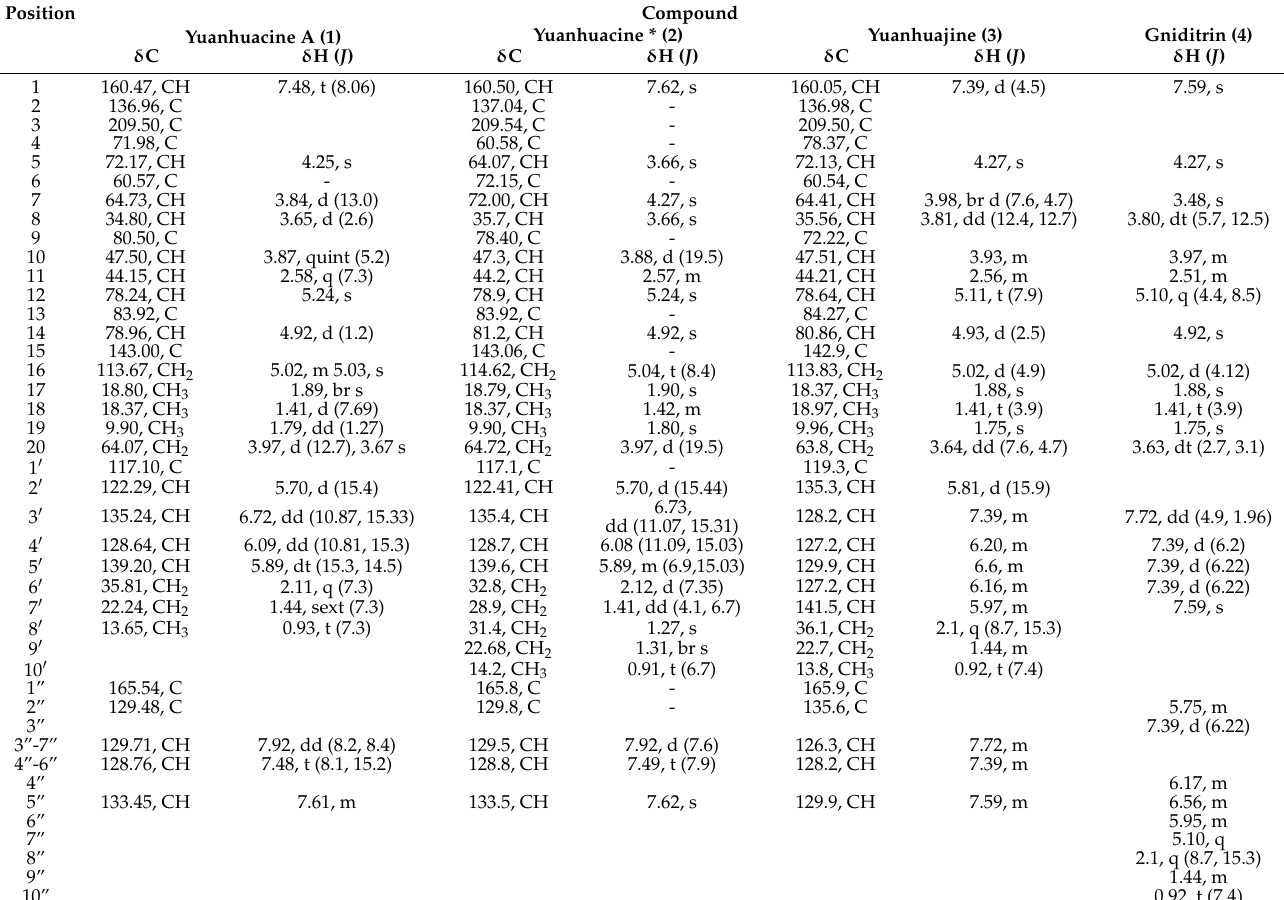
ionisation mode, yuanhuacine A appeared at m/z 621.0960 [M+H] + with a corresponding molecular formula of C 35 H 40 O 10 (calculated 621.0360) with 16 degrees of unsaturation, correlating to that observed in the literature [26]. The 1 H-NMR spectrum revealed proton signals and 13 C atoms which were in accordance with the molecular formula. The 1 H-NMR spectrum indicated the presence of four methyl groups at δ H 1.89 (3H, br. s, H-17), 1.79 (3H, dd, J = 1.27 Hz, H-19), 1.41 (3H, d, J = 7.69 Hz, H-18), and 0.93 (3H, t, J = 7.3 Hz, H-8 (cid:48) ). The presence of a phenyl group was shown by the signals at δ H 7.92 (2H, dd, J = 8.2, 8.4 Hz, C-3 (cid:48)(cid:48) and C-7 (cid:48)(cid:48) ), 7.48 (2H, t, J = 8.1, 15.2 Hz, C-4 (cid:48)(cid:48) and C-6 (cid:48)(cid:48) ), and 7.61 (1H, m, C-5 (cid:48)(cid:48) ) (Table 1). The DEPT NMR spectrum showed the presence of an α , β -unsaturated ketone at δ C 209.50 (C-3). DEPT confirmed the presence of 10 quaternary carbons with a carbon– oxygen bond, six olefinic carbons, and five methylene carbons. The signal at δ C 117.10 (C-1 (cid:48) ) is an indication of an orthoester moiety formed between C9/C13/C14 at δ C 80.50 (C-9), 83.92 (C-13), and 78.96 (C-14). There was an indication of an ester moiety at δ C 165.54 (C-1 (cid:48)(cid:48) ) and an epoxy ring found at C-6 and C-7 at δ C 60.57 and 64.73, respectively. The effect of the α , β -unsaturated ketone resulted in the downfield chemical shift for C-19 at δ C 9.90 (Table 1). The presence of three alcohol groups, δ C 64.07 (C-20), a primary alcohol; δ C 72.17 (C-5), a secondary alcohol; and δ C 71.98 (C-4), a tertiary alcohol, were detected. The HSQC and COSY correlation led to the assignment of the proton and carbon signals. The 1 H and 13 C chemical shifts are shown in Figures S1 and S2, respectively (Supplementary File), where comparisons are drawn with the published literature [26]. Based on these results, the compound was confirmed to be yuanhuacine A (Figure 3A, compound 1 ). Table 1. 1 H and 13 C NMR Spectroscopic Data for compounds 1 , 2 , 3 and 4 (CDCl 3 , 500